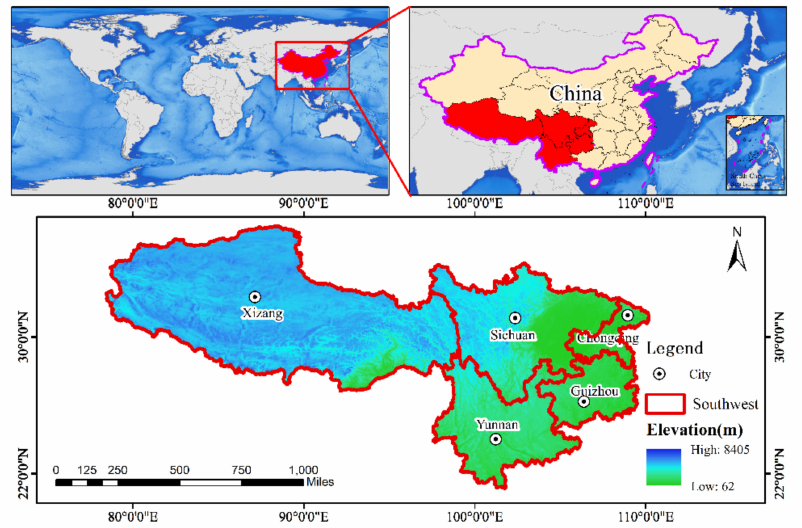
Figure 1. Geographical location of the study